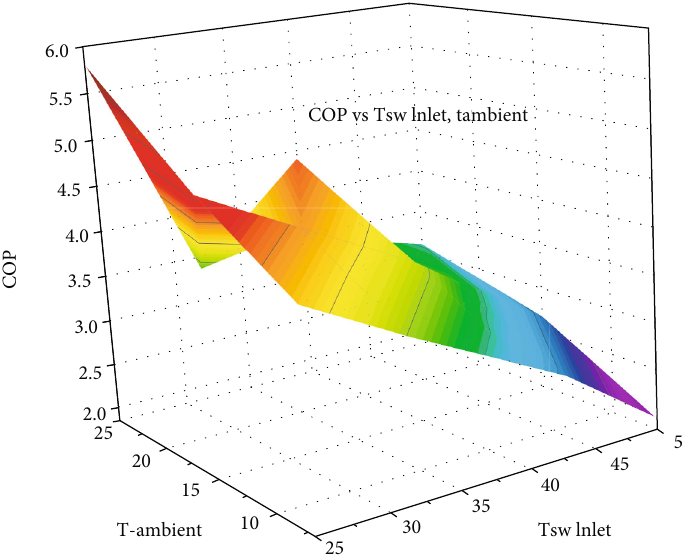
Figure 4: COP as a function of ambient and heat pump hot water tank